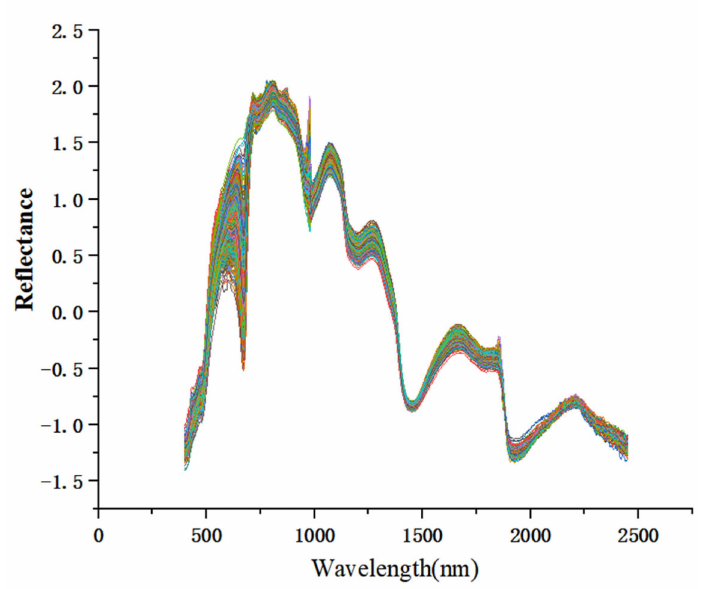
Figure 5. Spectral profile of pear samples after pretreatment with the SNV method in the wavelength range of 400–2450